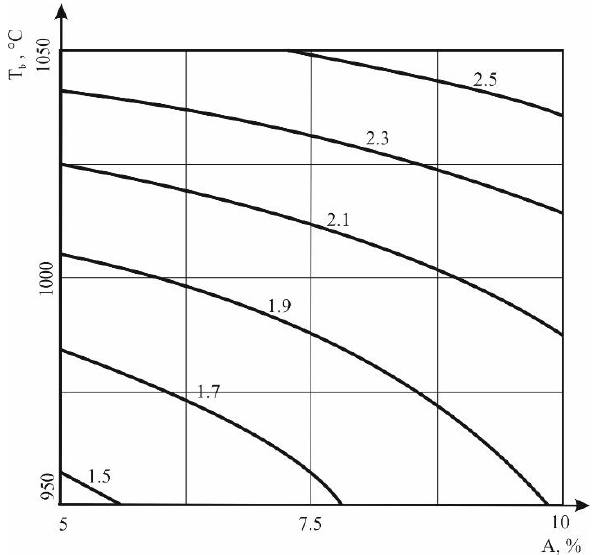
Figure 2. Dependence of fire shrinkage (FS) on the amount of additive in the clay and the temperature of raw firing. Equation of the dependency graph: FS = 2 + 0.17x + 0.43y + 0.01x 2 − 0.06xy + 0.09y 2 .